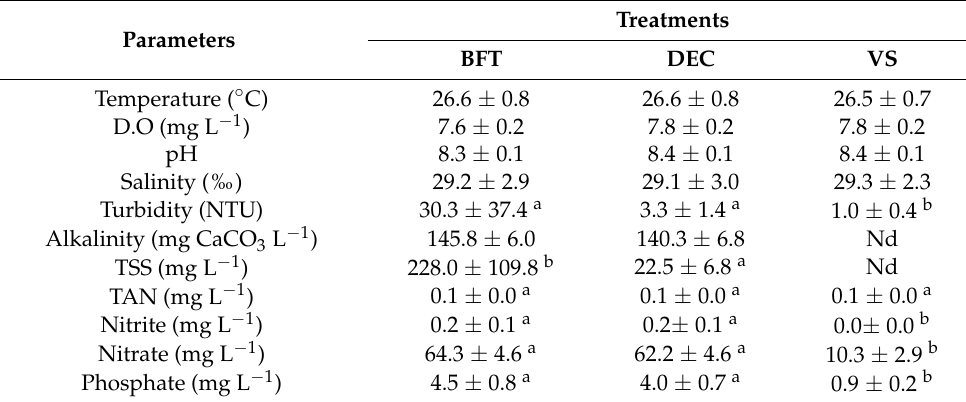
Table 3. Water quality parameters (mean ± standard deviation) in the treatment groups where U. lactuca was cultivated in different shrimp effluent concentrations (BFT: with 400 mg L − 1 of TSS; DEC: with 30 mg L − 1 of TSS; and VS: cultivation of U. lactuca in von Stosch enrichment solution at a concentration of 10 mL L − 1 ) during the 35 days of the experimental